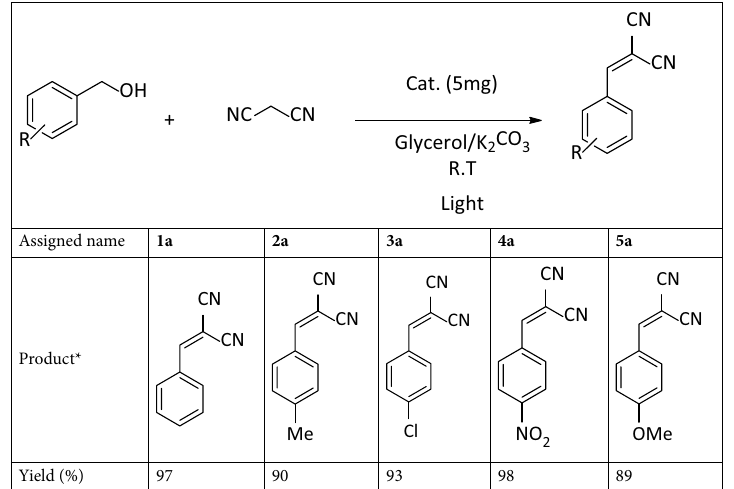
Table 3. Light-excited preparation of various 2-benzylidenemalononitrile derivatives in the presence of GO-MIL-100(Fe). *Reaction conditions: Substrates (1 mmol), Glycerol/K 2 CO 3 (2:1) (5 mL), 5 mg of the catalyst at room temperature under light irradiation for 420 min.